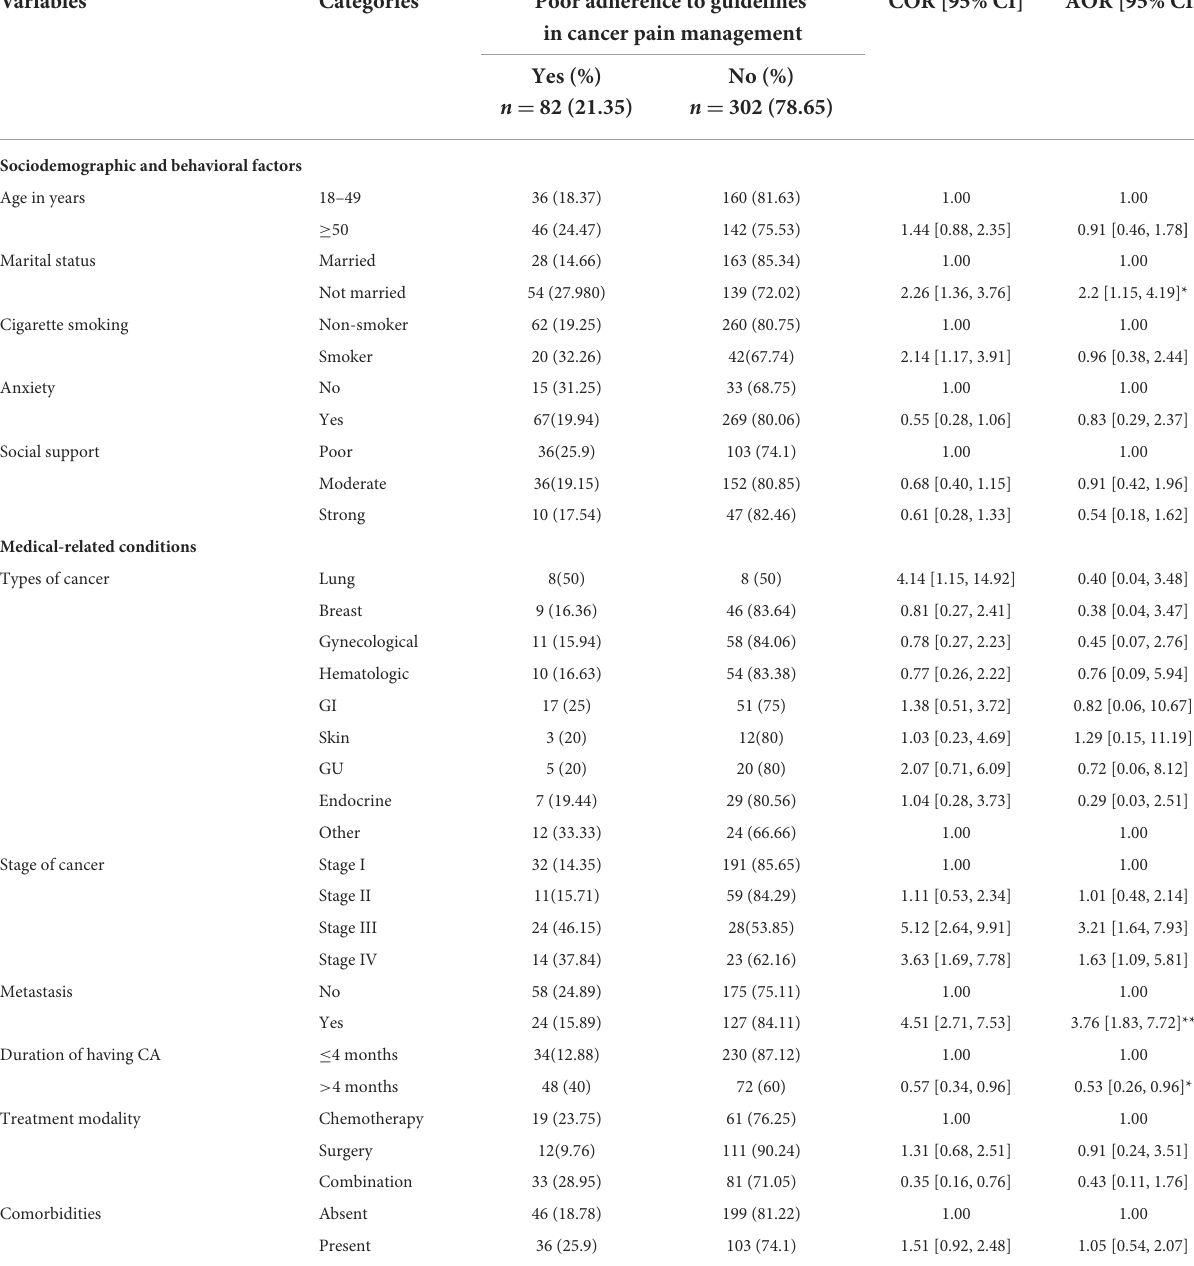
TABLE 2 Bivariable and multivariable analyses of factors associated with poor adherence to guidelines in cancer pain management among patients in the UoGCSH, Northwest Ethiopia 2021.